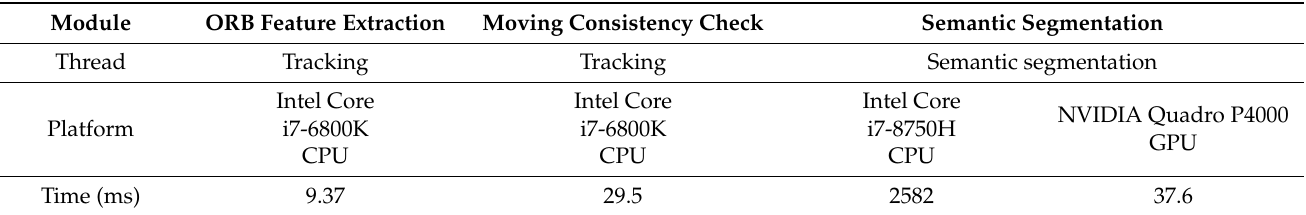
Table 1. Execution time of different modules in the Semantic Simultaneous Localization and Mapping towards Dynamic Environment (DS-SLAM) algorithm